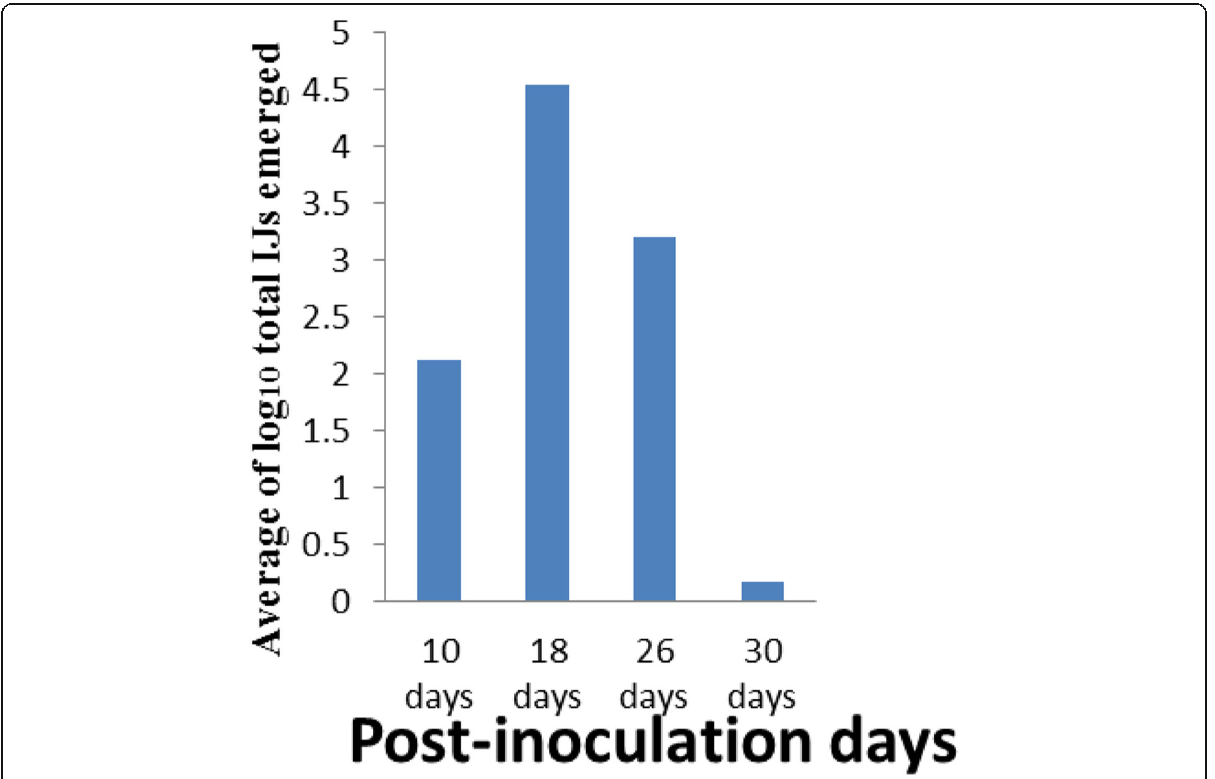
Fig. 3 Average numbers of emerging infective juveniles (IJs)/ Temnorhynchus baal larva for 23 Heterorhabditis indica populations in loamy sand soil. Numbers among all post-inoculation days are significantly ( P ≤ 0.05) different according to